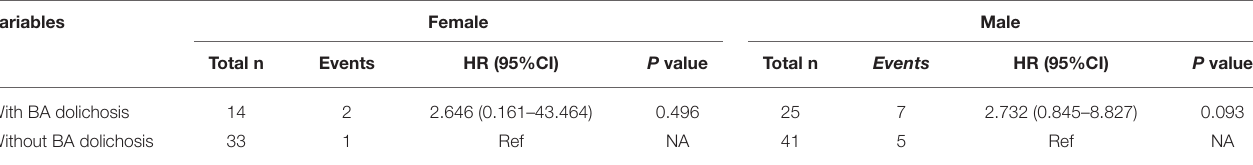
TABLE 4 | Subgroup analysis stratified by